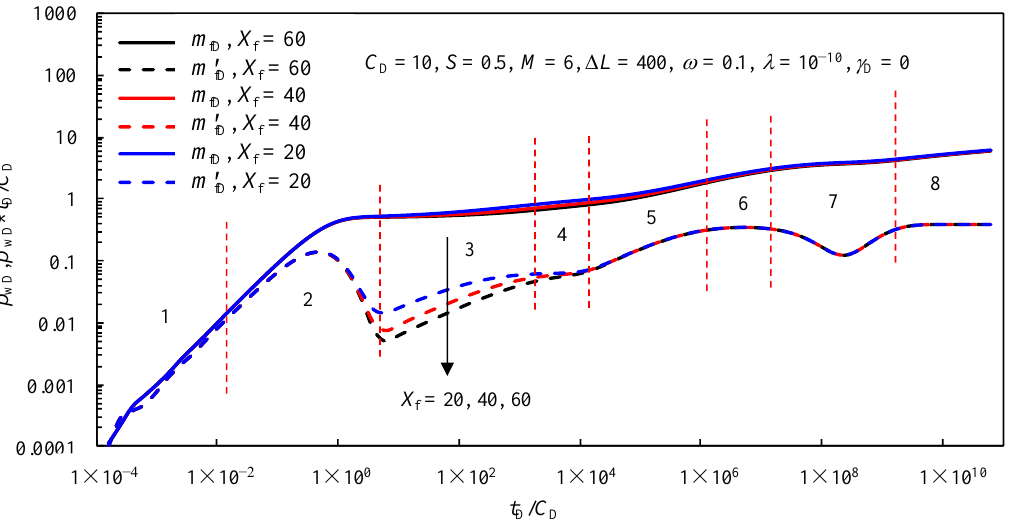
Figure 10. The effect of the fracture’s half-length on the dimensionless pressure and pressure derivatives of a MFHW in an inter-salt shale oil reservoir.